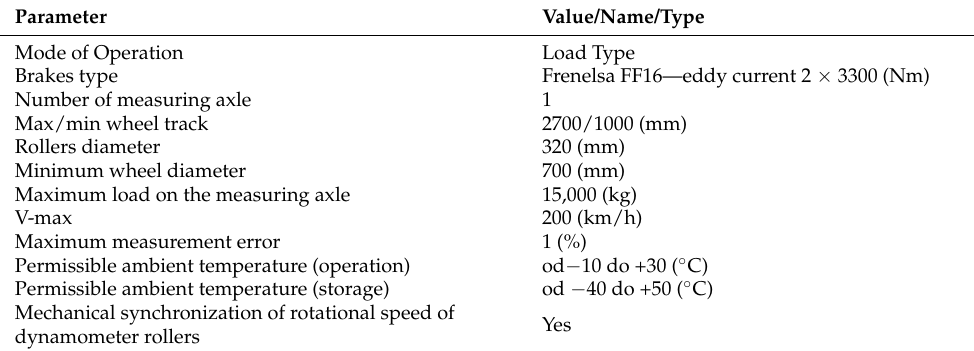
Table 1. Selected declared parameters of the mobile dynamometer device according to the design assumptions and the manufacturer (manufacturer data).